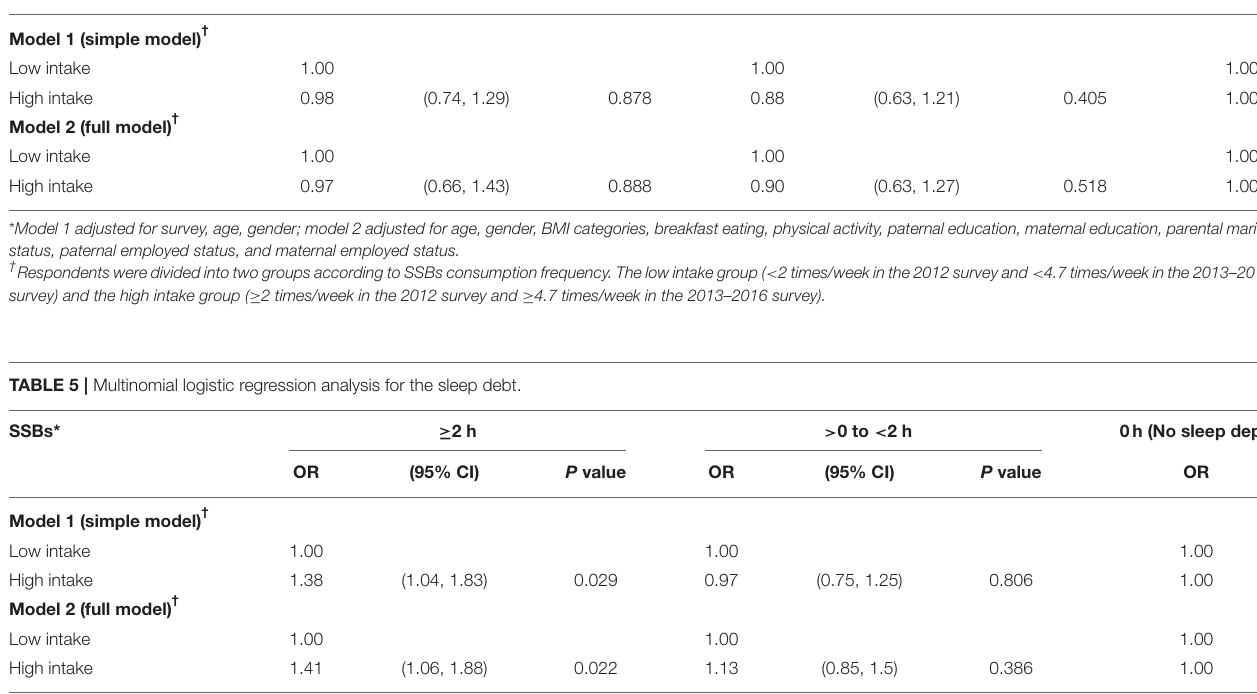
TABLE 4 | Multinomial logistic regression analysis for the sleep duration on weekends. SSBs* < 9 h ≥ 9 to < 10.5 h ≥ 10.5 h OR (95% CI) P- value OR (95% CI) P -value OR Model 1 (simple model) †